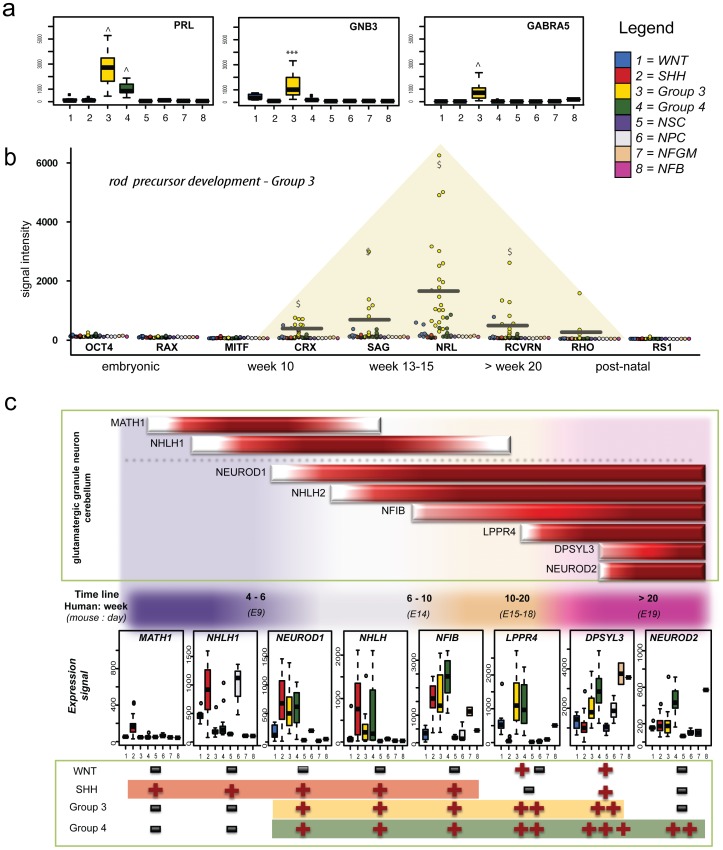
Developmental alignment of Group 3 and Group 4 medulloblastoma.
a. The expression levels of selected exclusively Group 3 over-expressed photoreceptor and glutamate signaling genes were graphed for all sample groups using Box-Whisker plots. b. Expression of rod photoreceptor genes transiently and terminally expressed during retinal differentiation was graphed for all medulloblastoma and control samples. The mean expression and the time window of active rod gene expression for Group 3 medulloblastoma is indicated and emphasized by yellow shaded overlay. c. Developmental alignment of key transcription factors expressed during glutamatergic granule neuron development. Expression time frame during normal cerebellar maturation is indicated schematically in the top panel. Gene expression for medulloblastoma and control groups is shown in box-whisker plots. Developmental expression windows of time stamp genes in medulloblastoma subgroups are schematically displayed in the bottom panel. *** −p<0.001, $ –p<0.05 compared to all control groups with n>1 and exclusive for molecular subgroup, ∧ −p<0.05 compared to all control groups but not exclusive for medulloblastoma subgroup, NFB - normal fetal brain, NFGM - normal fetal germinal matrix, NPC - neural progenitor cells, NSC - neural stem cells.